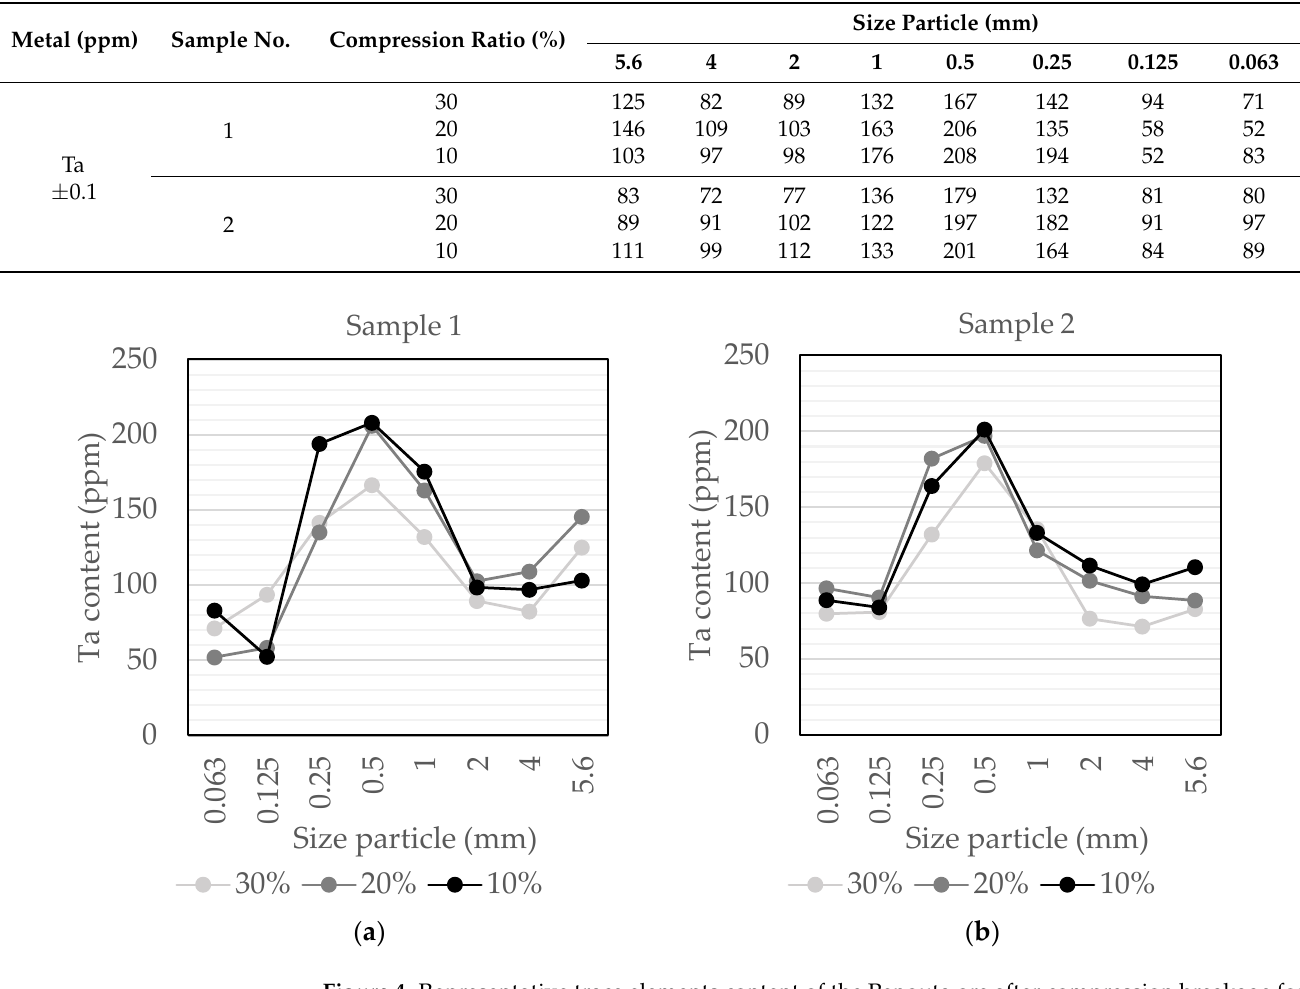
Table 1. Tantalum content in different size fractions of the Penouta ore after compression breakage at 30, 20 and 10% compression ratios for samples 1 and 2 [25].